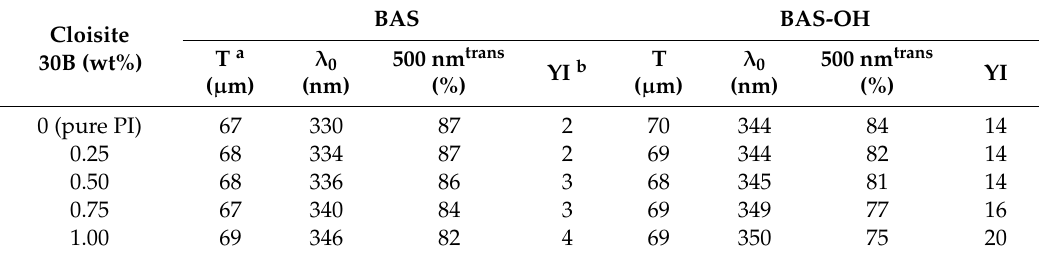
a Film thickness. b Yellow